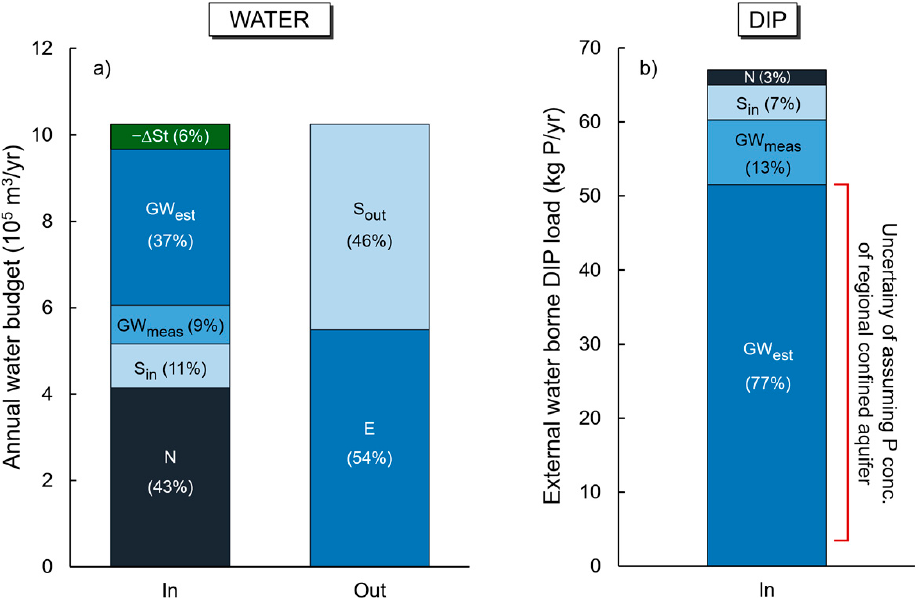
Figure 7. The annual water budget ( a ) and the annual external water-borne DIP loading ( b ) to Lake Nørresø from June 2016 to June 2017. In ( b ), the column is for the assumption that the groundwater input, GW est , derived from the water balance carried a DIP concentration representing the regional confined aquifer, i.e., the spring’s 4.6 µ M. Percentages in brackets indicate the relative water ( a ) or phosphorus (P) ( b ) contribution of precipitation (N), surface water input (S in , sum of streams 2–9), measured groundwater input (GW meas , sum of the spring and stream 1), estimated groundwater input (GW est , water budget residual), evaporation (E), surface water output (S out , via the outlet), and storage change ( ∆ St, the lake water level decreased during the investigated hydrological year).